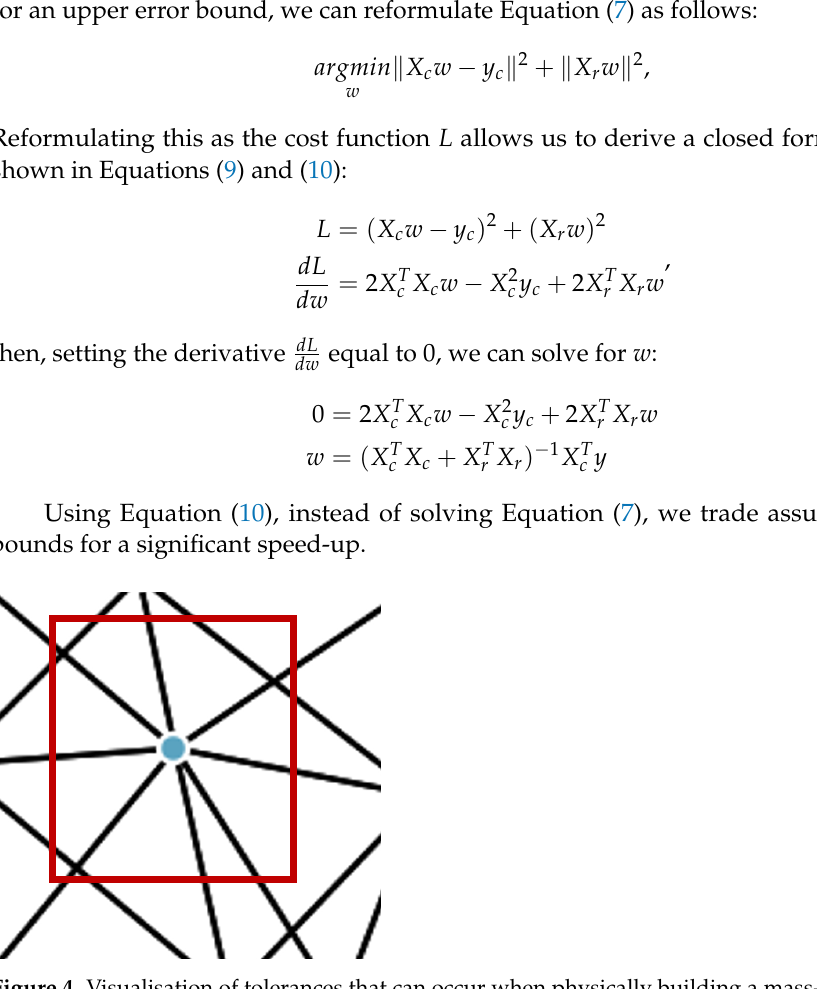
Figure 4. Visualisation of tolerances that can occur when physically building a mass-spring network. The light blue circle represents the exact location of the mass and the red rectangle represents the area of possible locations due to tolerances in horizontal and vertical directions. Such tolerances can change the dynamical behaviour of the network compared with simulated the counterpart, and poses a major obstacle when trying to transfer learnt parameters from simulation to real-world